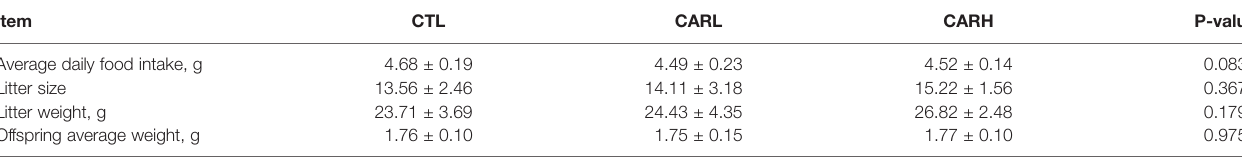
TABLE 1 | Effect of b -carotene on litter performance of